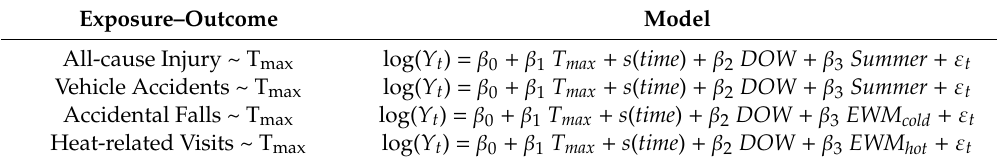
Table 8. Model frameworks used to evaluate each exposure–outcome pair.